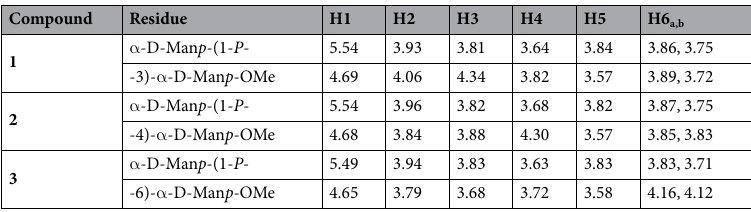
Table 1. 1 H chemical shifts ( δ , ppm; CD 3 OD) of compounds 1–3 .